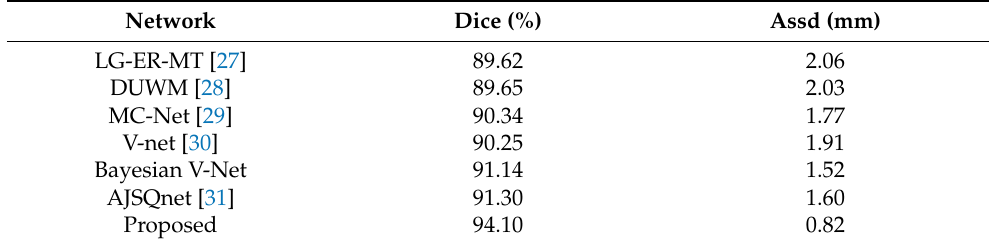
Table 4. Performance comparison of our method and compared